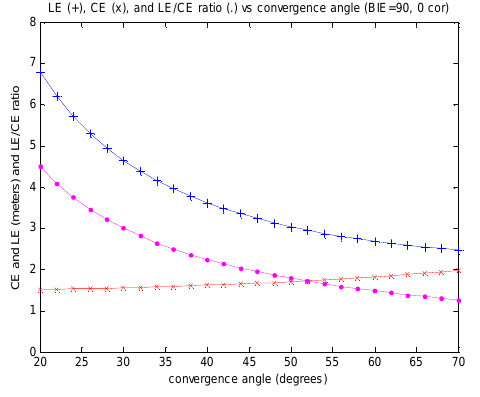
Figure 7. LE, CE, LE/CE vs. convergence angle